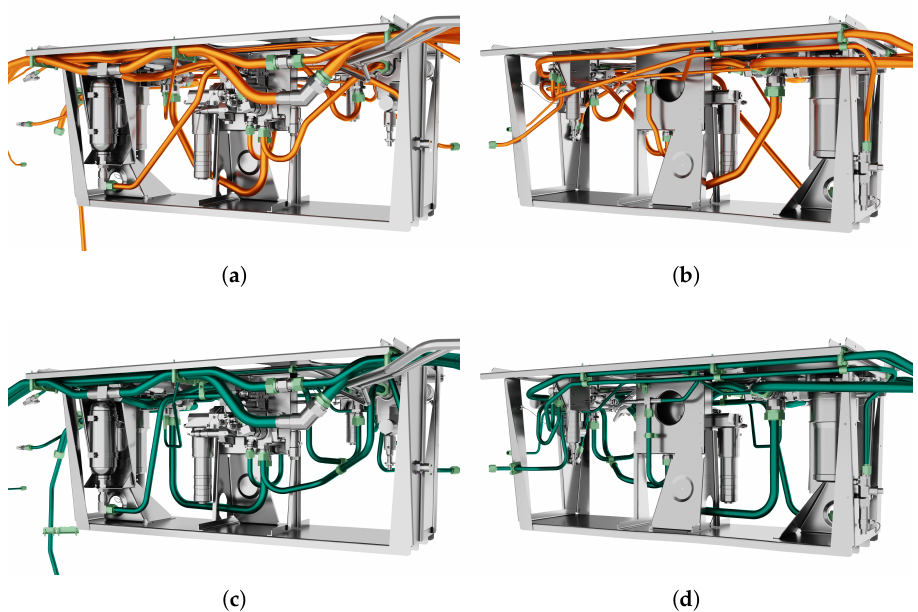
Figure 12. Automatically generated (orange) and manually designed pipes (green) in an Airbus A320 mounting rack. ( a ) Automatically generated pipes (seen from the left side), ( b ) Automatically generated pipes (seen from the right side), ( c ) Manually designed pipes (seen from the left side), ( d ) Manually designed pipes (seen from the right side).